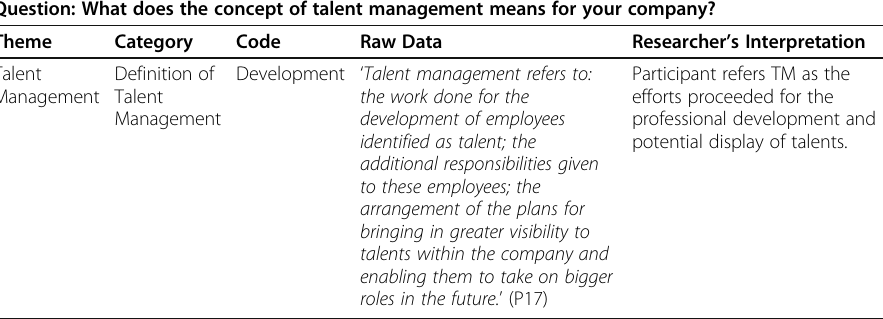
Table 1 Coding and categorization example in data analysis process Question: What does the concept of talent management means for your